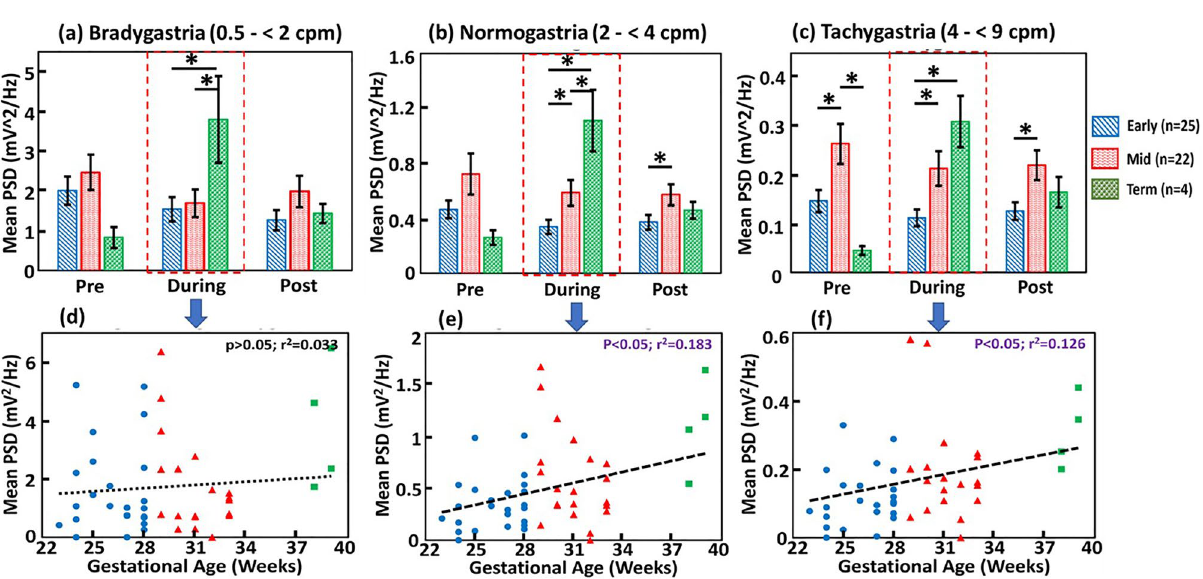
Figure 3. Mean power spectral density ( m PSD) increases with maturation during feeding. Group-level comparisons of GA-dependent m PSD values (mV 2 /Hz) taken pre-, during, and post-feeding period in ( a ) bradygastria, ( b ) normogastria, and ( c ) tachygastria, respectively. “*” indicates the statistical significance with p < 0.05; the red boxes mark the During-feed periods. ( d – f ) show the corresponding linear regressions of ( a ) to ( c ) between GA of infants and m PSD, respectively, in the During-feed